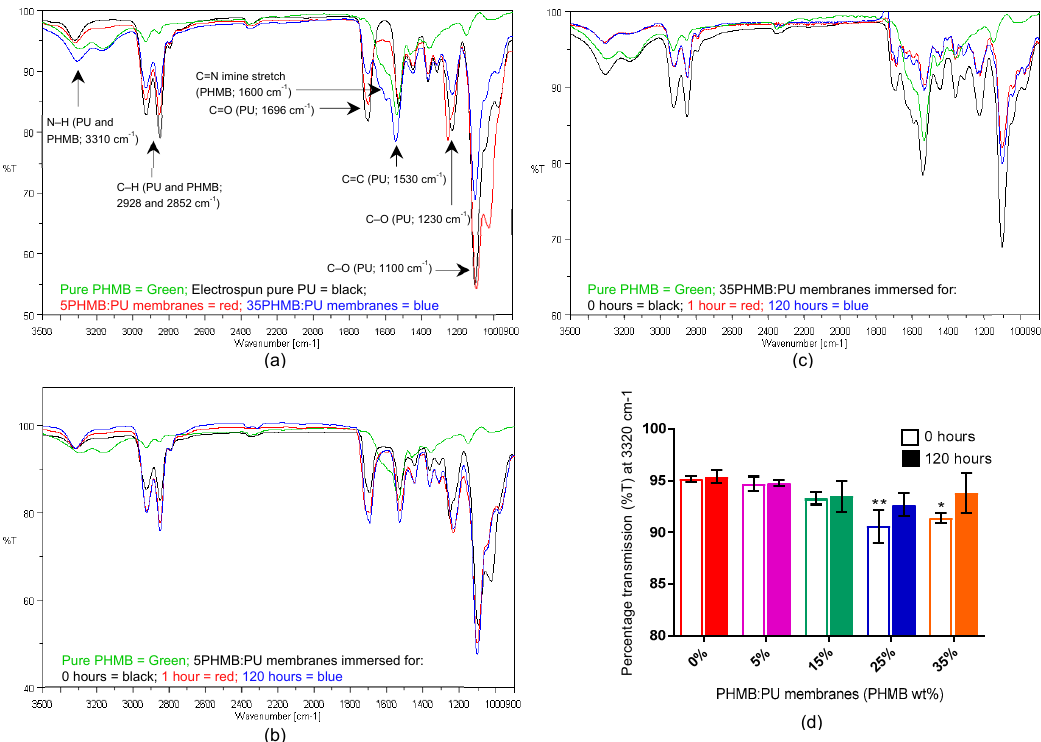
Figure 3. FTIR measurements of PHMB:PU electrospun membranes. ( a ) Pure PHMB (green), untreated membranes: 0-, 5- and 35PHMB:PU electrospun membranes (black, red and blue respectively). ( b ) and ( c ), 5- and 35PHMB:PU membranes respectively that were immersed in PBS for 0, 1 and 120 hours (black, red and blue respectively). These were compared to pure PHMB (green). ( d ) Percentage transmission for the 3320 cm − 1 peak (N–H) before and after membranes were immersed in PBS for 0 and 120 hours. * indicates a significant difference (* for p < 0.05; ** for p < 0.001).